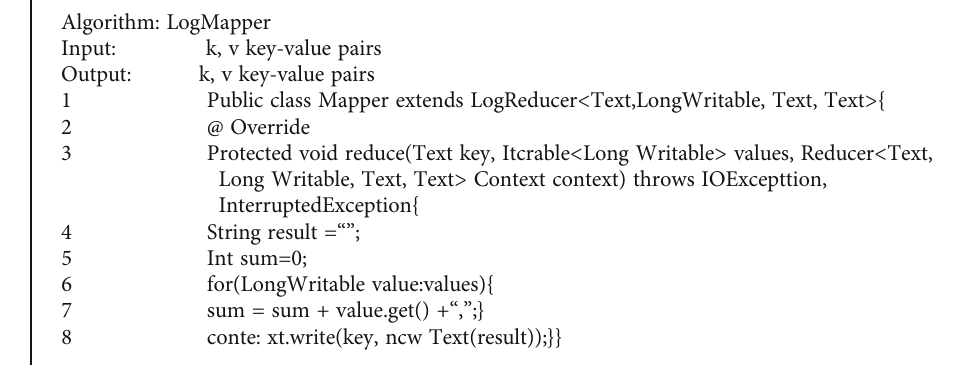
Algorithm 2: Reduce class pseudocode.